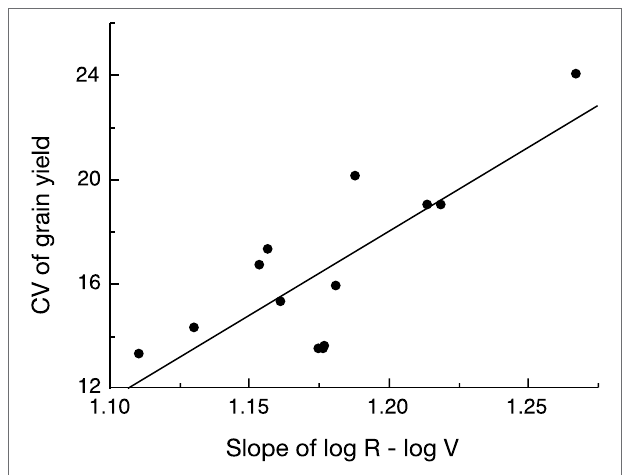
FIGURE 3 | Linear regression of coefficient of variation (CV) of yield versus slope of the log (reproductive biomass, R)–log (vegetative biomass, V) relationship for 13 genotypes of winter wheat grown at nine environments in Gansu Province, China [data from Zhao (2020); Yan-Lei Du, unpublished]; p =